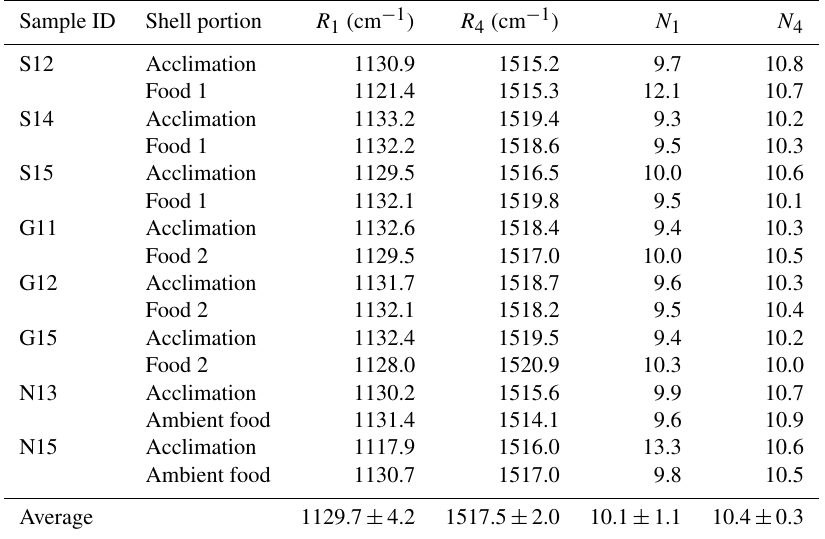
Table 2. Details of the pigment composition of the Arctica islandica shells used in the food experiment. The position of the major polyene peaks R 1 and R 4 in the Raman spectrum is indicated together with the number of single and double carbon bonds of the pigment molecular chain ( N 1 and N 4 ). Each shell was analyzed in the portions formed before and during the experimental